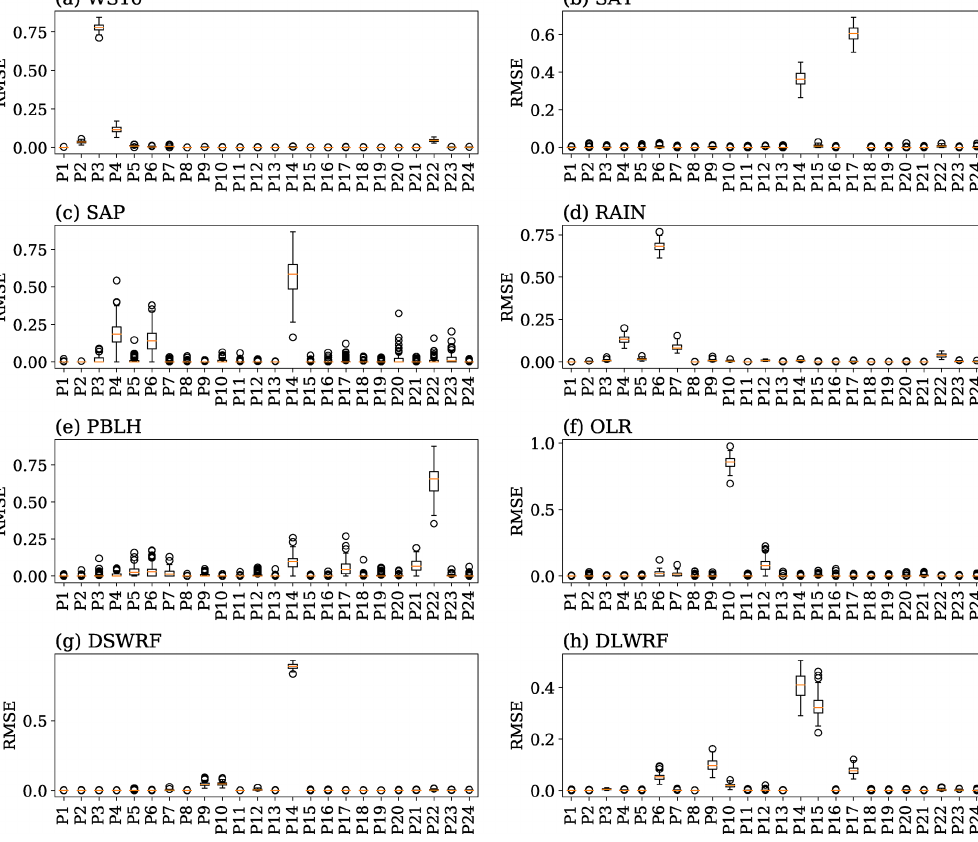
Figure 6. Boxplot of the normalized GCV scores of 24 parameters, for the meteorological variable considered, with the MARS method. Each dataset is created by 100 applications of bootstrap resampling out of 250